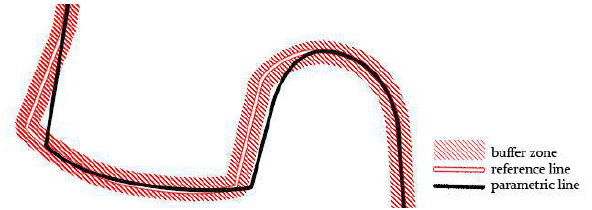
Figure 5. To validate the parametric line, we assess the percentage of this line inside the buffer zone.